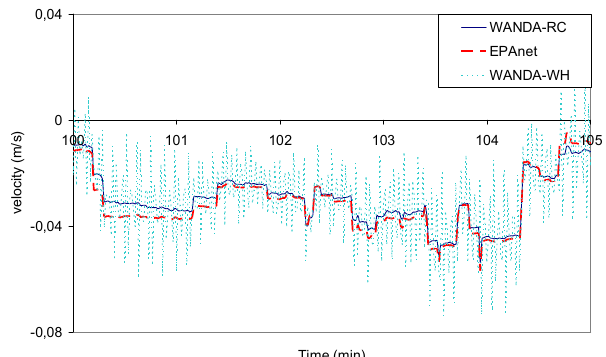
Figure 5. 5-min detail of the three modelling approaches in pipe e Figure 5: 5-minute detail of the three modelling approaches in pipe e (100 = 6:40 AM). 2 (100 =